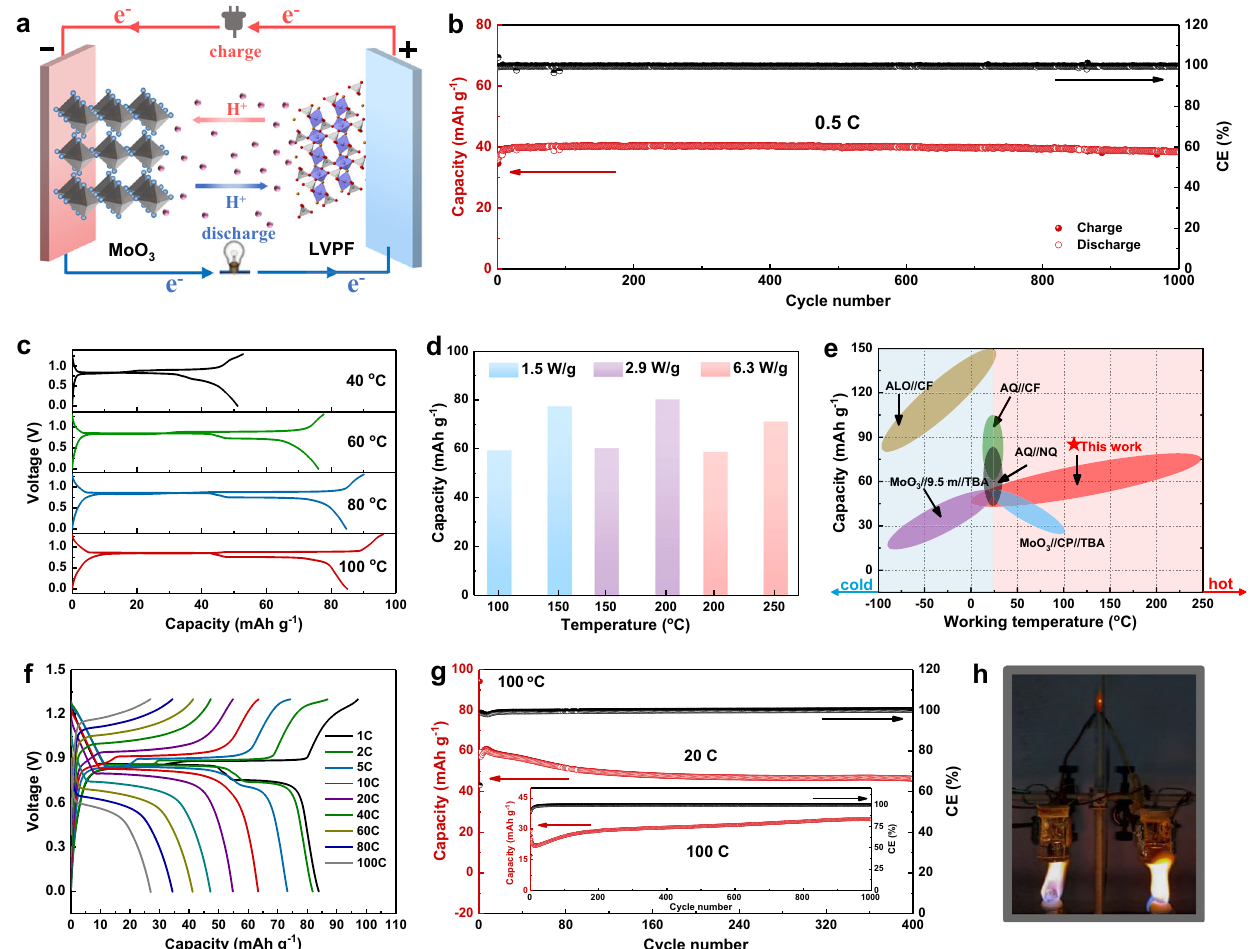
Fig. 5 | Electrochemicalperformance oftheMoO 3 ||LVPF full cell.a Schematic of thebattery. b Cyclingperformanceatarateof0.5Catroomtemperature. c Voltage pro fi lesatdifferenttemperaturesatarateof0.5C. d Reversiblespeci fi ccapacityin differenttemperatures. e Comparisonoftheworkingtemperatureandcapacityfor